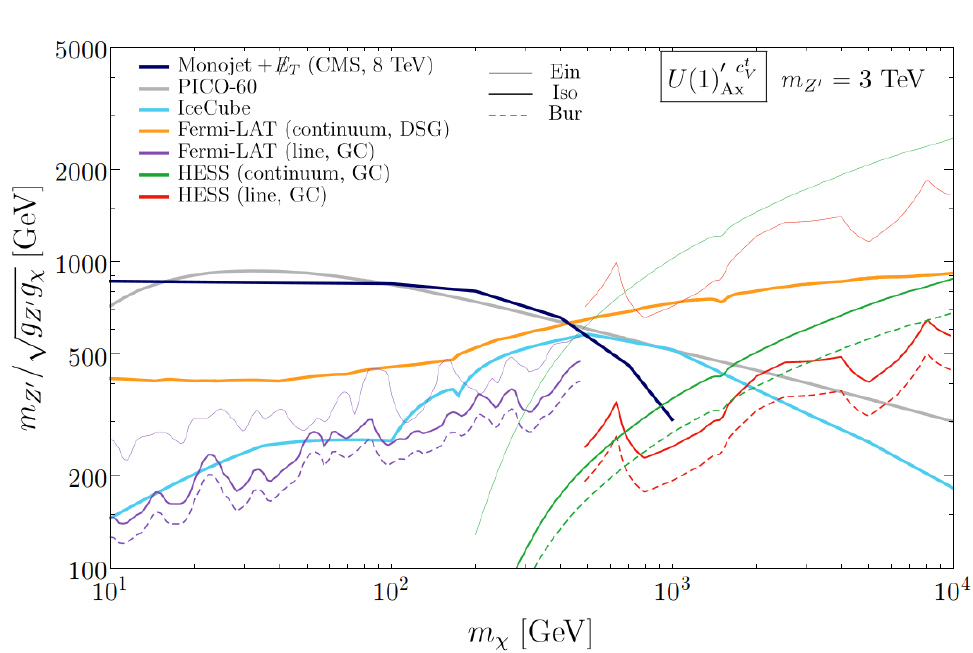
Figure 10 . Combined limits from indirect detection, collider, and direct detection bounds on the t U(1) 0 c V ax model with a 3 TeV mediator. For heavy DM, the anomaly-induced annihilations to gauge